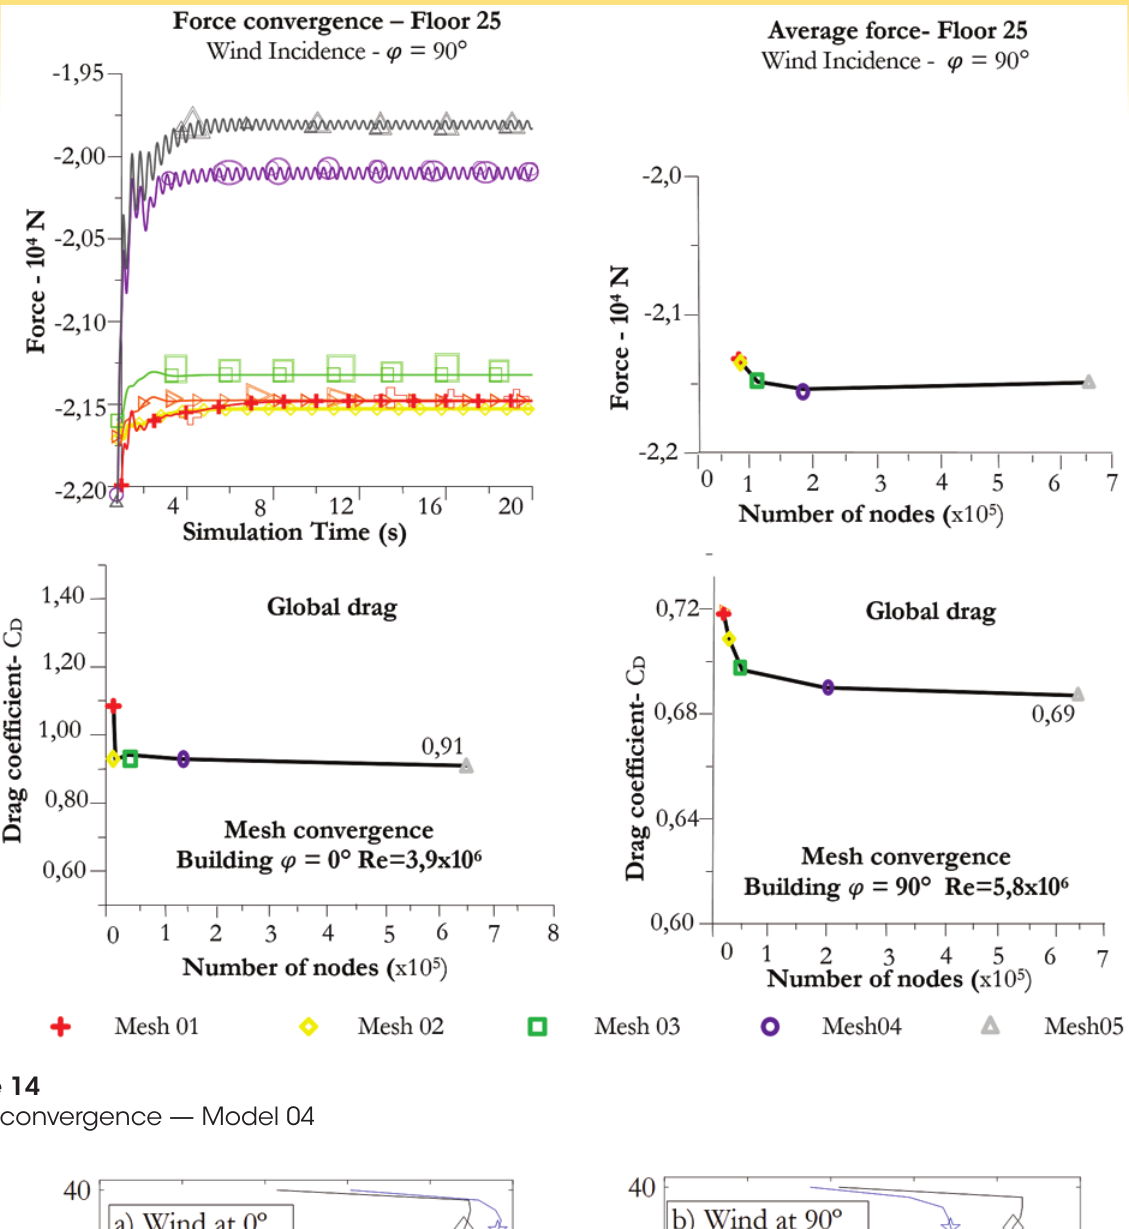
Figure 14 Mesh convergence — Model 04